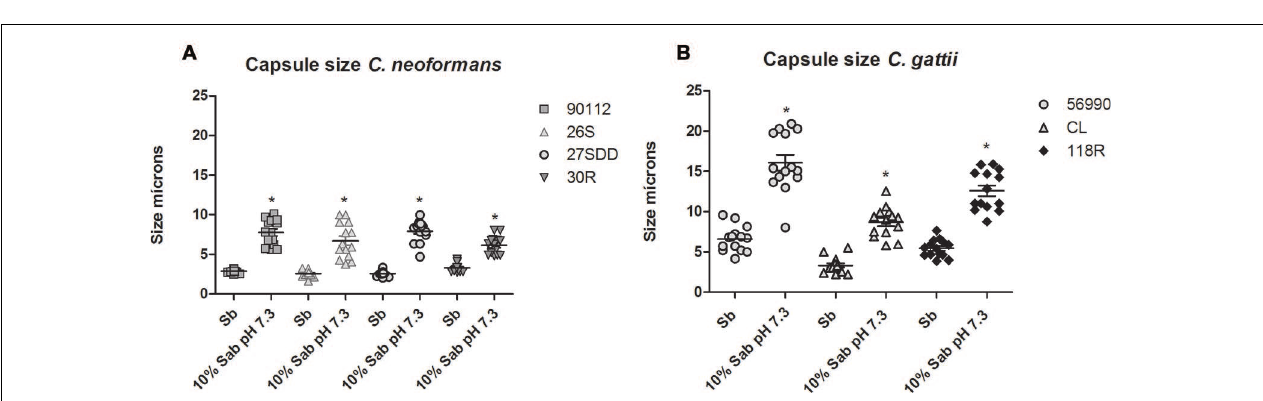
FIGURE 3 | Quantification of melanization of C. gattii and C. neoformans isolates after inoculation in G. mellonella . The quantification was measured at different times, 1 and 5 h. (A) C. neoformans 1 h; (B) C. neoformans 5 h; (C) C. gattii 1 h; and (D) C. gattii 5 h. ∗ p < 0.05.